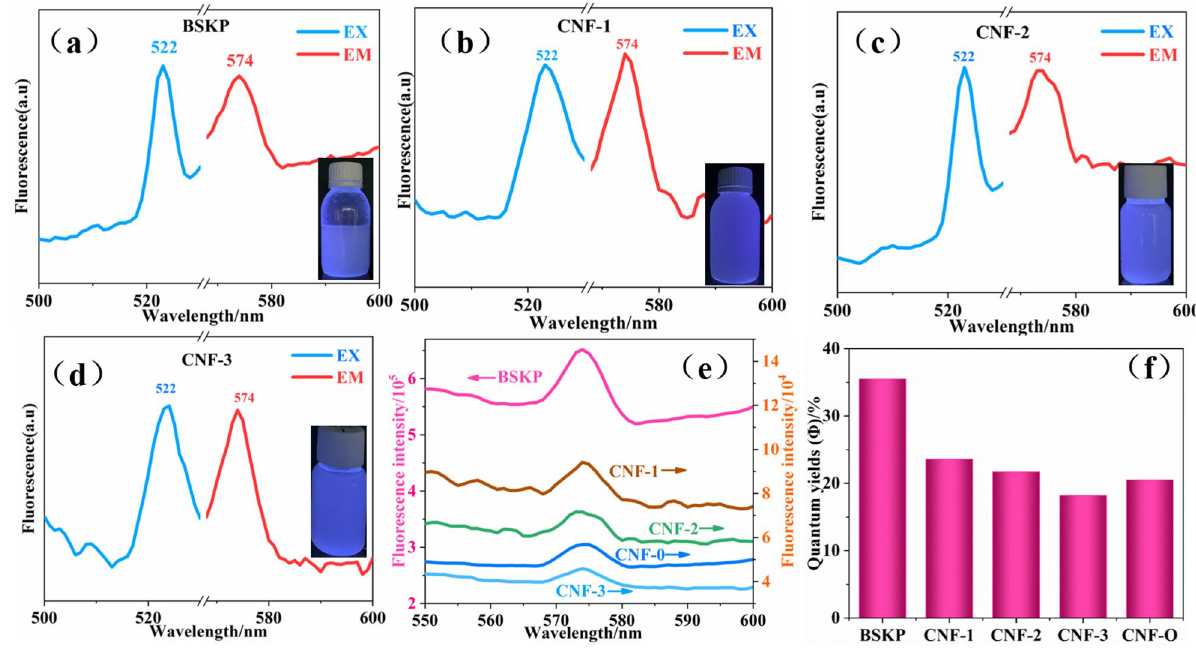
Figure 2. Fluorescence spectrum with inset showing the fluorescence pictographs (EX: excitation spectrum, EM: emission spectrum) of ( a ) BSKP, ( b ) CNF-1, ( c ) CNF-2, ( d ) CNF-3. ( e ), ( f ) Comparison of fluorescence intensity and